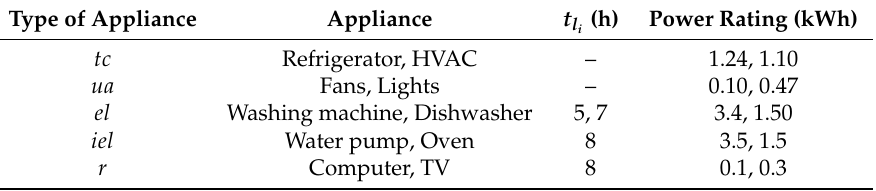
Table 3. Appliances energy consumption and operating time [33].